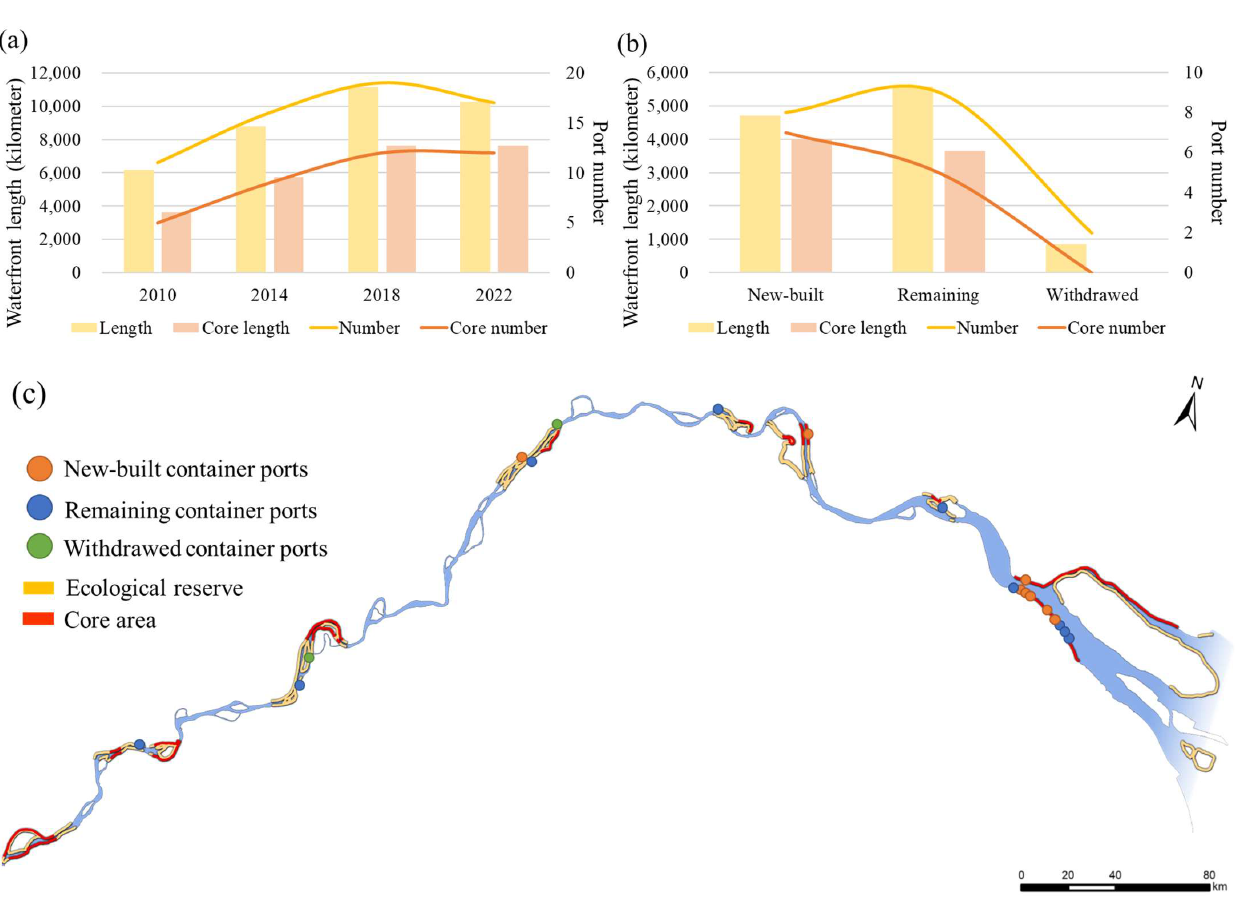
Figure 6. Conflicts between container port waterfront and protection reserve. ( a ) length of ecological reserve occupied by container ports, ( b ) length of ecological reserve occupied by container ports in different states, ( c ) distribution of ecological reserve occupied by container ports.